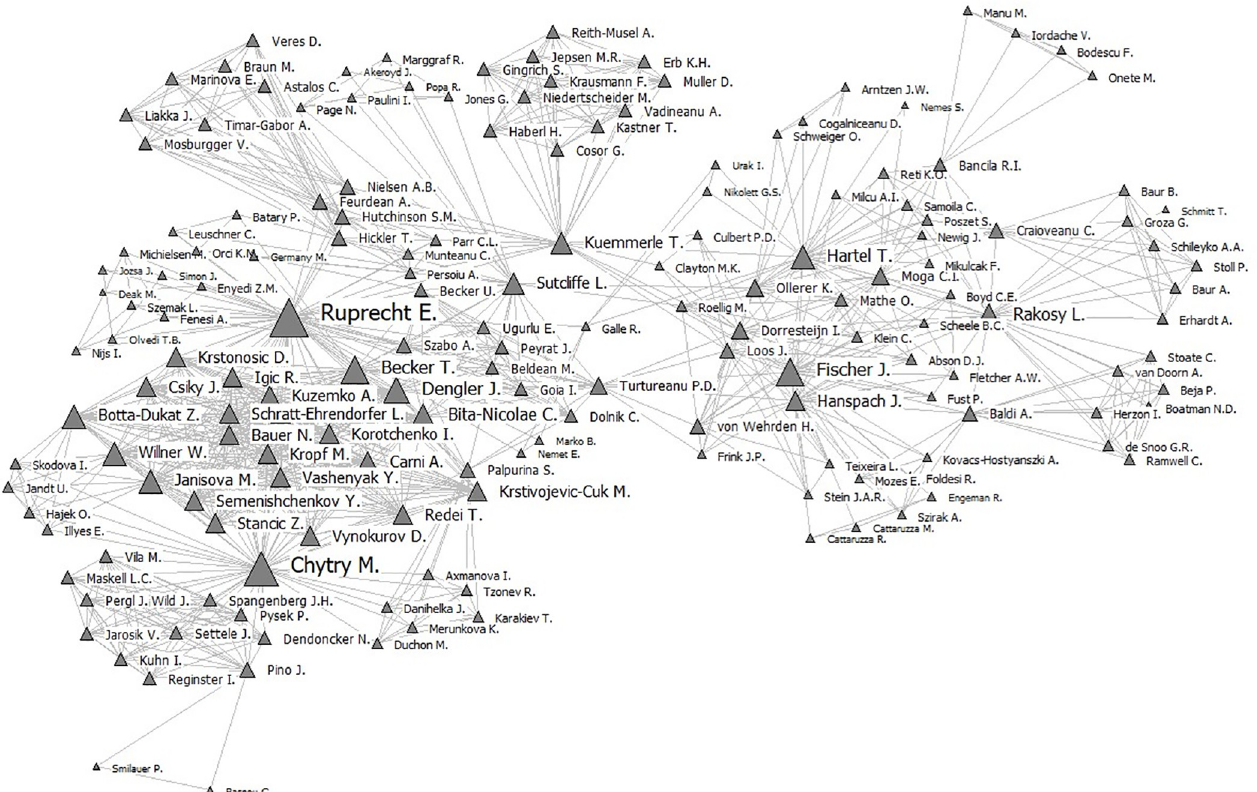
Fig 6. Main components of the network of authors publishing work about Romania’s grasslands (nodes size by